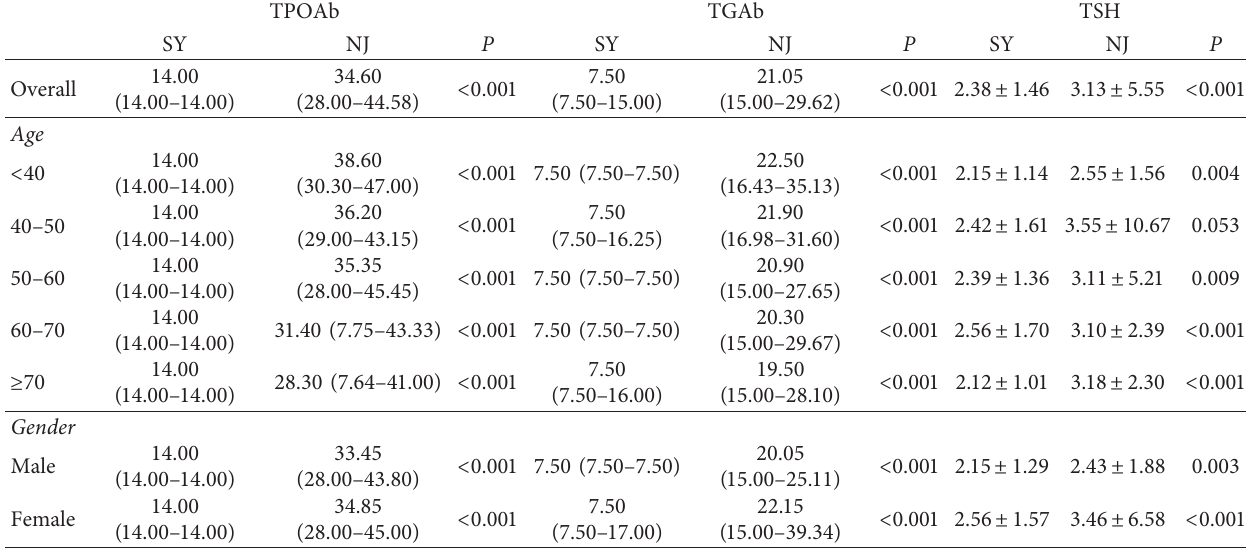
Table 1: Comparison of TSH, TPOAb, and TGAb concentrations in two